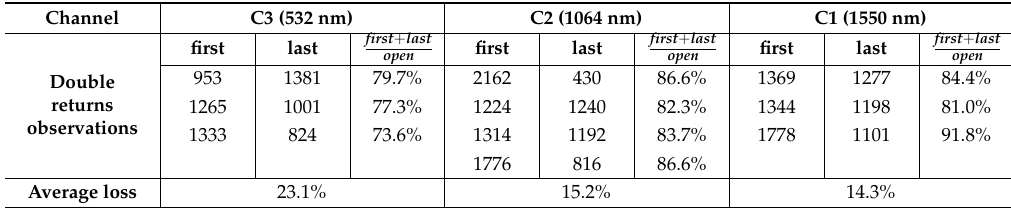
Table 6. Lifted target calibrated digital numbers (DNs) from double returns (first and last) with the percentage of the sum relative to the open target DN for each channel. The average loss in comparison to the open target is shown in the bottom